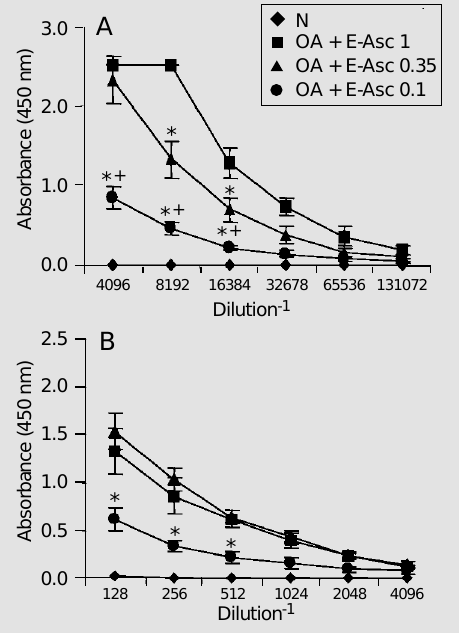
Asc)-specific IgG1 (A) and IgG2a (B) antibodies produced by mice immunized with different doses of E-Asc (1, 0.35 and 0.1 mg). Isotype levels in normal (N) or immune plasma were titrated by ELISA using monospecific anti- sera. The results represent the mean ± SEM absorbance for 5-7 animals. *P<0.05 compared with OA + E-Asc (1 mg)-immu- nized group (Tukey test). + P<0.05 compared with OA + E-Asc (0.35 mg)-immunized group (Tukey